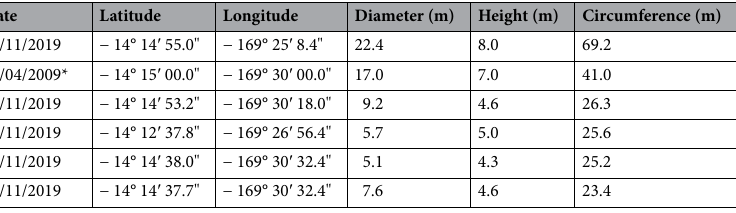
Table 1. Measurements and locations of the largest colonies of massive Porites spp. found around Ta‘u, American Samoa in November, 2019. *Previous measurements of a massive Porites sp. documented by Brown et al. 13 are included for comparison.